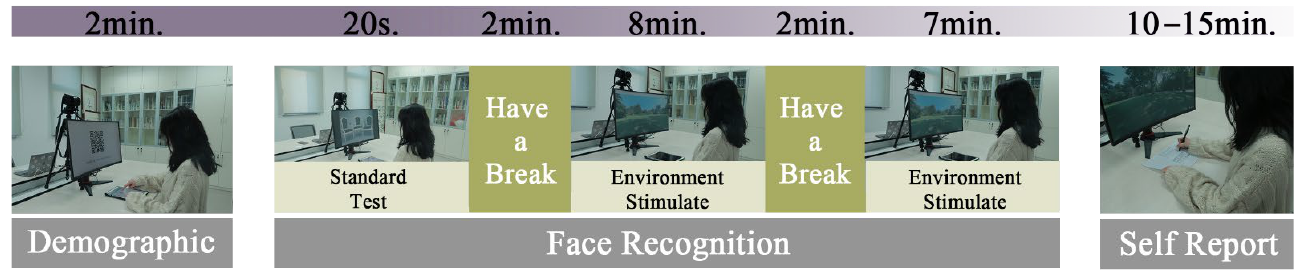
Figure 2. Preparation and experimental procedure.